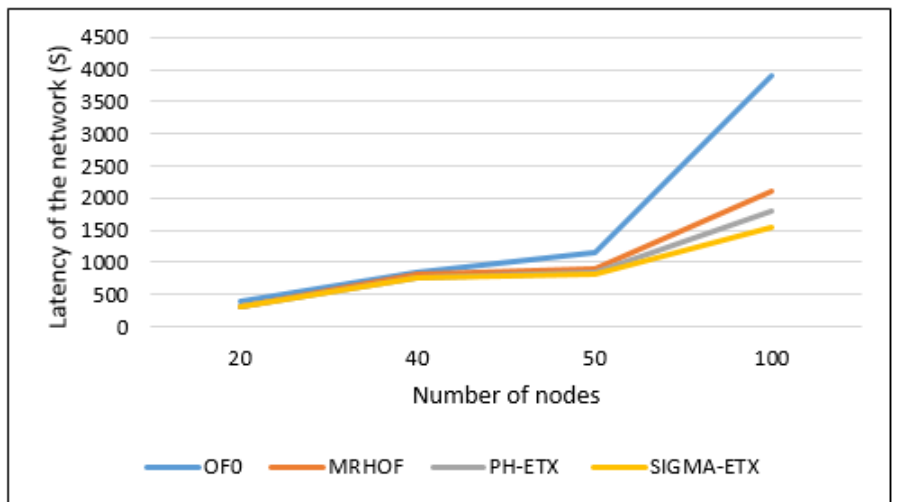
Figure 12. Latency with different nodes .